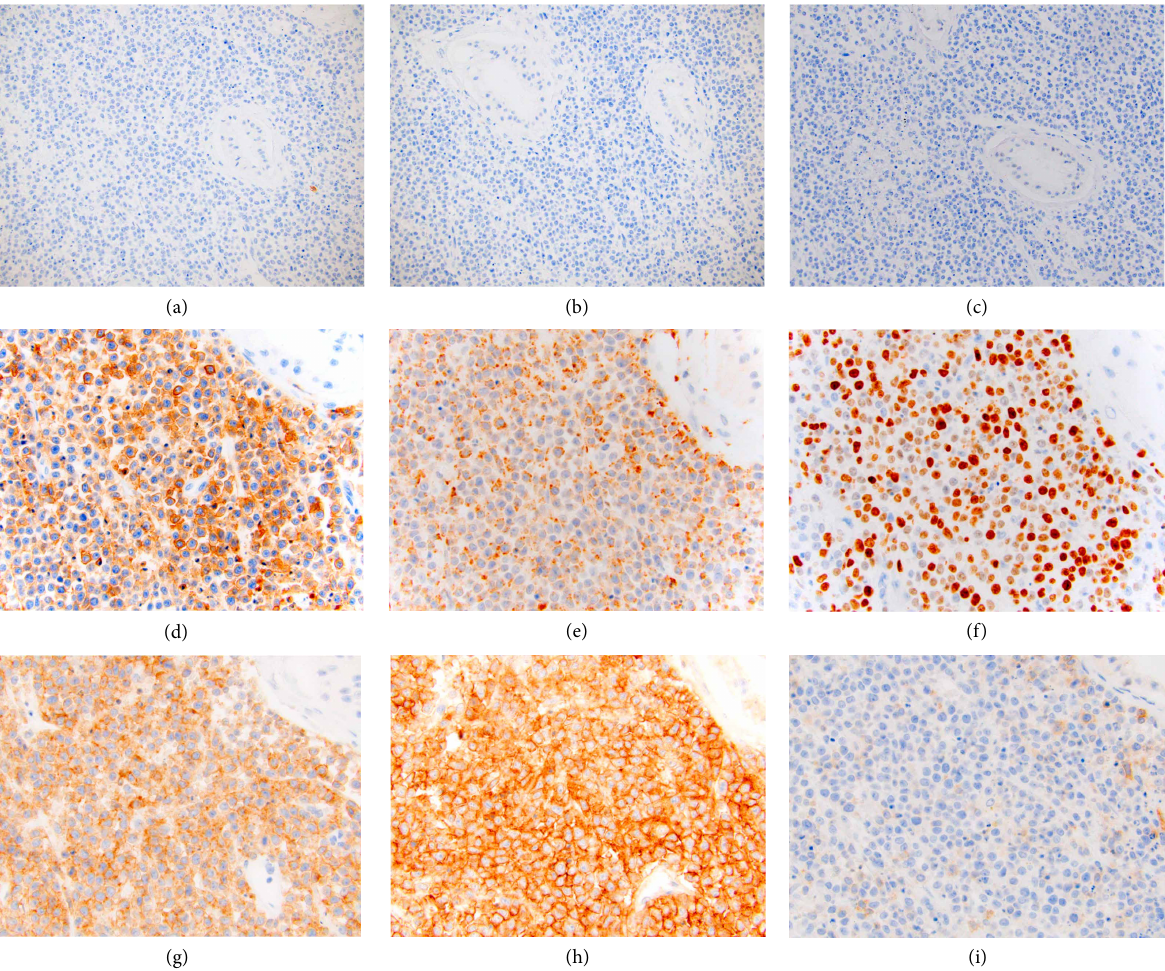
Figure 2: Representative immunohistochemistry images. Initial IHC panel of CD3 (a), CD20 (b), and SALL4 (c), was negative and argued against a diagnosis of lymphoma, primary germ cell tumor, or epithelial neoplasm. The neoplastic cells were weakly positive for CD45 (d), and granularly positive for CD68 (e), with dot-like pattern. Ki-67 (f), was expressed in 80% of cells. The diagnosis of BPDCN was consistent with positive CD4 (g), CD56 (h), and weak CD123